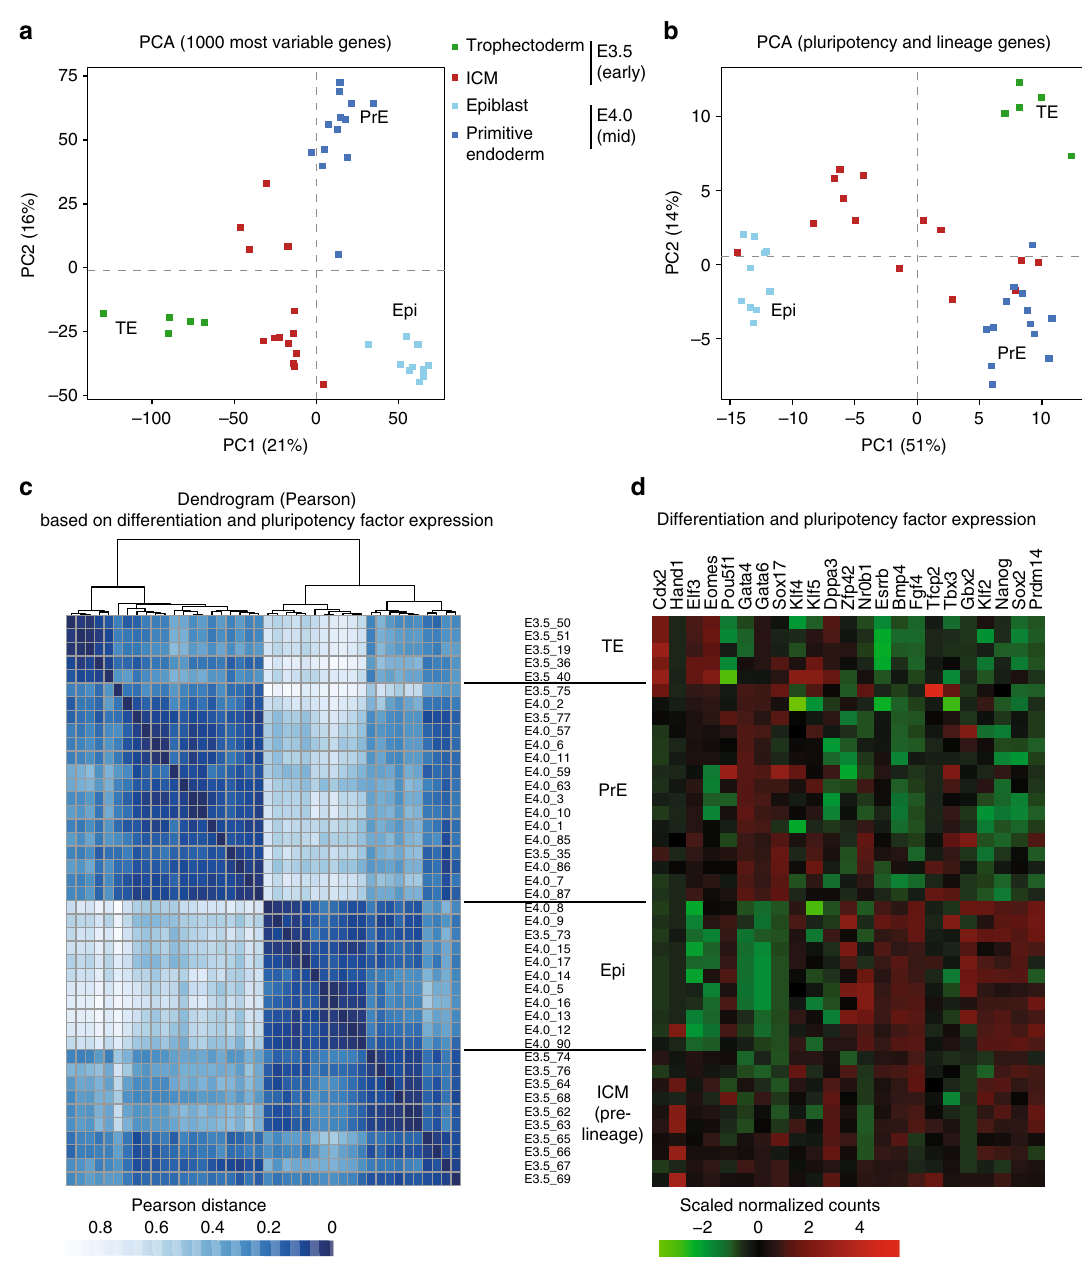
Fig. 3 Single-cell RNAseq reveals loss of heterogeneity in the E4.0 mid ICM compared to early E3.5 ICM. Principal component analysis (PCA) based on scRNAseq data from trophectoderm (E3.5), early (E3.5, 10 – 25 cells per ICM) and mid (E4.0, 20 – 40 cells per ICM). ICM cells on the 1000 most variable genes ( a ) and on published pluripotency and differentiation candidate genes ( n = 23, list in d ) ( b ). Different stages are designed by different colours. n = 14, 23 and 5 cells, respectively, for E3.5 ICM, E4.0 ICM and E3.5 TE (details of each single cell is listed in Supplementary Data 1). c Hierarchical clustering (top) and Pearson distance (bottom) of pluripotency and lineage genes (listed in d ) expression variation in E3.5 and E4.0 single cells, based on Pearson ’ s correlation. Cells were clustered by lineage (TE, PrE and Epi), then by stage. n = 42 single-cell samples. d Level of expression of the 23 candidate genes involved in pluripotency and lineage differentiation in the 42 single-cell samples and used to classify cells according to their lineage are shown. Cells were ordered according to the hierarchical clustering in c . TE trophectoderm, PrE primitive endoderm, ICM inner cell mass, Epi